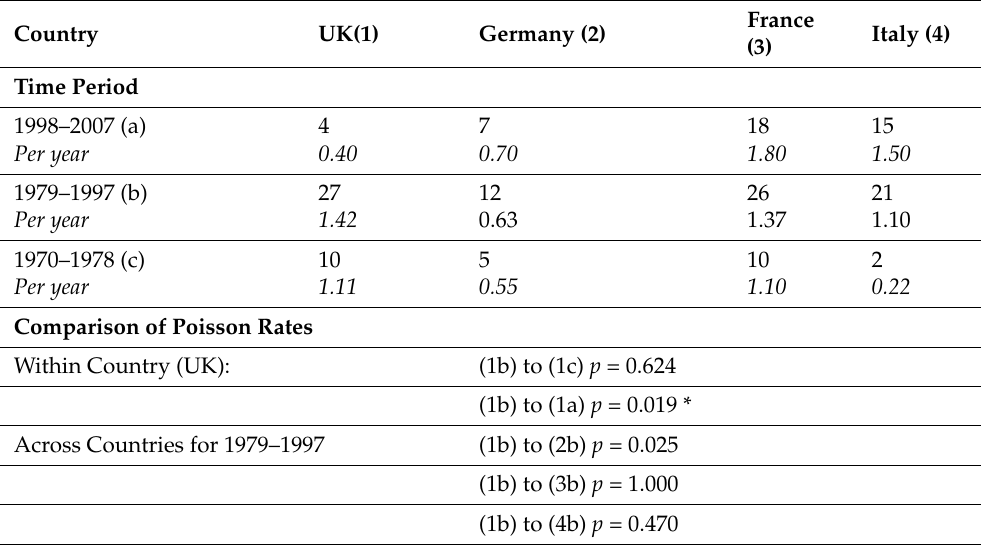
Table 1. Total and per Year Number of Multi-fatality Disasters, 1970–2007. Country